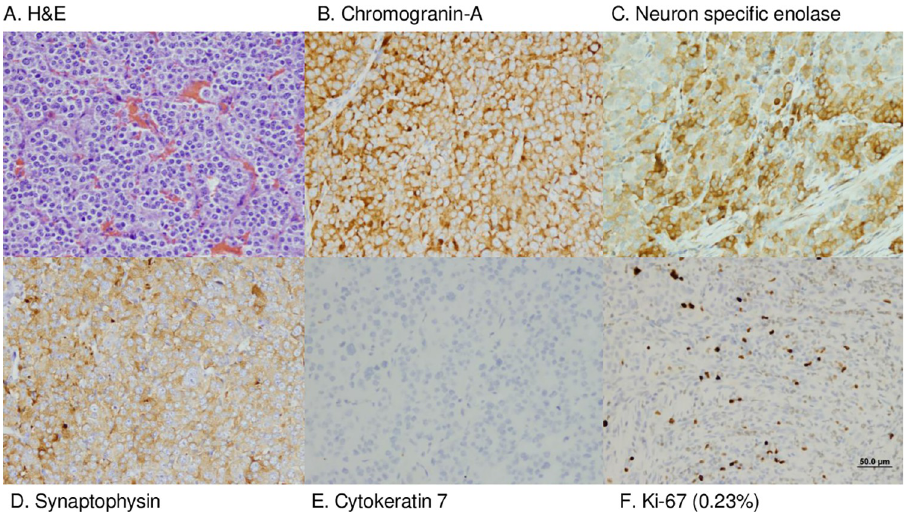
Fig 2. Neuroendocrine neoplasm H&E histology and immunohistochemical staining. H&E stained gallbladder neuroendocrine neoplasm (A). Neoplastic cells exhibited positive immunoreactivity for chromogranin A (B), neuron specific enolase (C), and synaptophysin (D); cytokeratin 7 staining was negative (E) and few neoplastic cells were Ki-67 positive (F). Scale Bar = 50 μ m.